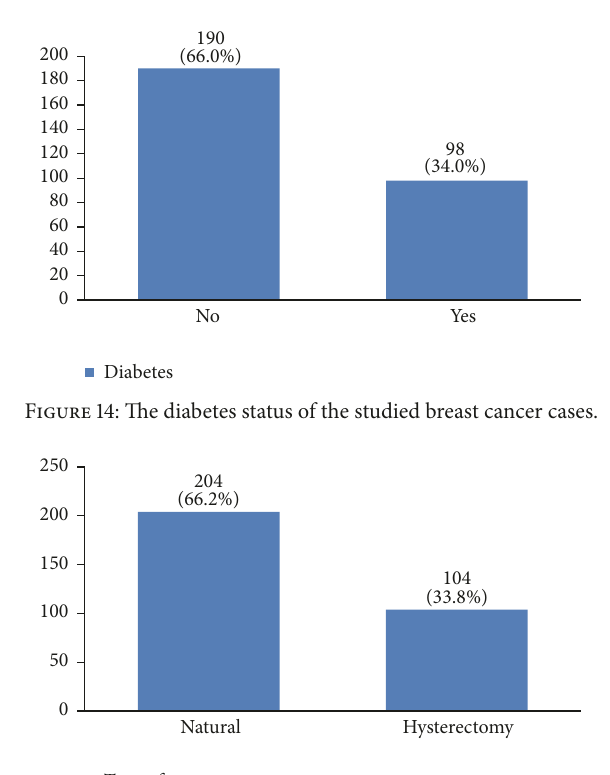
Figure 13: The smoking habit of the studied breast cancer cases.